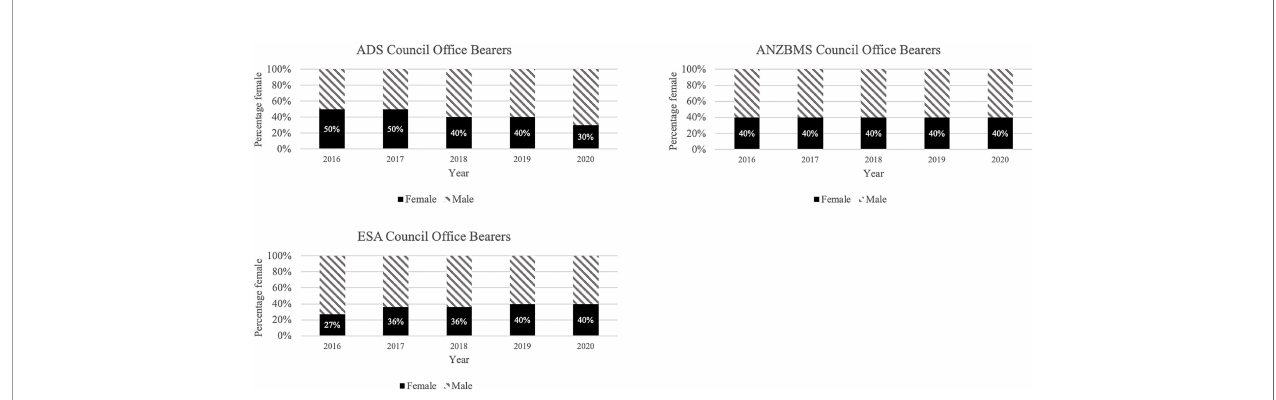
FIGURE 4 | Proportion of society council members by gender. ADS, Australian Diabetes Society; ANZBMS, Australian and New Zealand Bone and Mineral Society; ESA, Endocrine Society